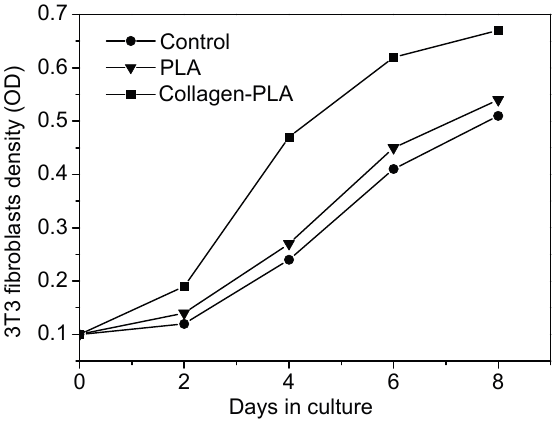
Figure 6. Cell growth curves of 3T3 fibroblasts on PLA and collagen-PLA with glass as control. The proliferation of 3T3 fibroblasts on the samples surfaces was presented in Figure 7.